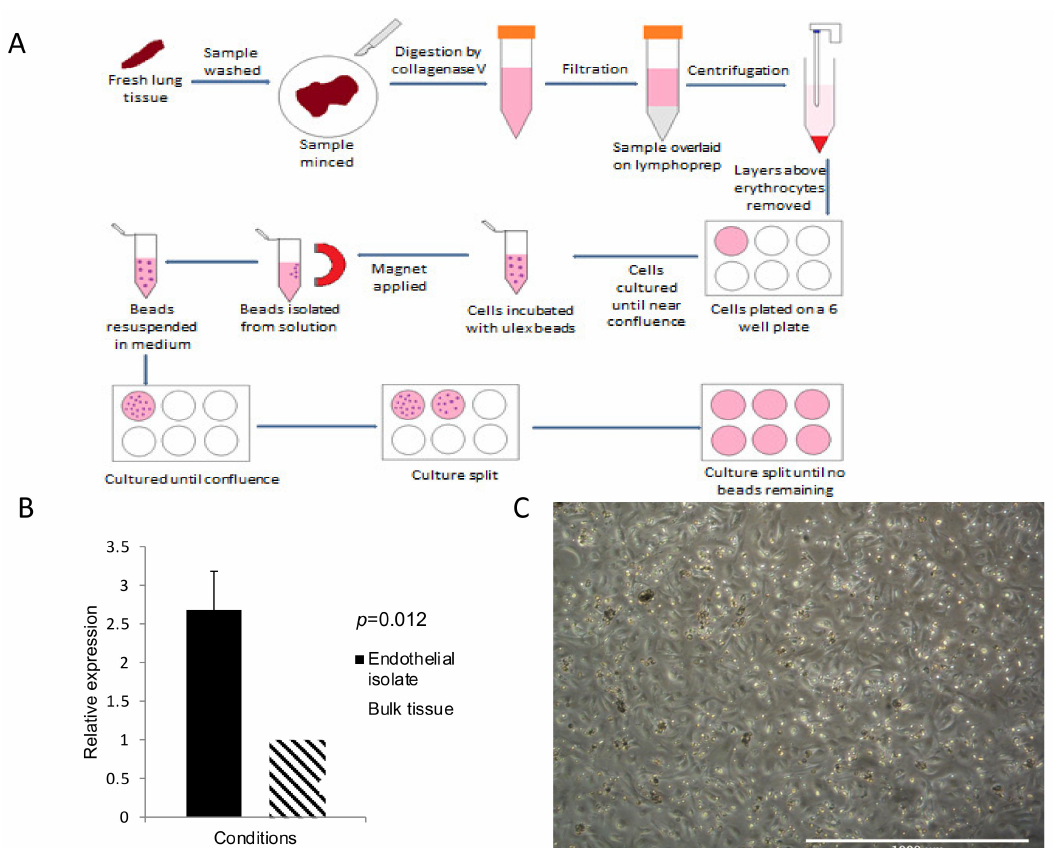
Figure 1. Isolation and culture of endothelial cells. ( A ) Workflow: Fresh lung is minced before being added to collagenase V, the digested sample is passed through a filter before being overlaid on lymphoprep, cell layers above the erythrocytes are removed and the cell pellet resuspended and placed in a 6-well plate. The cell culture is then incubated with Ulex-coated magnetic beads, which bind to endothelial cells, before a magnet is used to isolate the beads. Cells are used either for RNA extraction at this point, or the beads are resuspended and cultured by placement in a 6-well plate, the culture being split repeatedly until no beads remain. ( B ) Confirmation of isolation efficiency by qPCR: the bar chart represents the relative expression of CD31 in endothelial isolates in comparison to bulk tissue, normalised against flotillin 2. ( C ) Appearance of mixed lung cell culture on day five, extraction four. Primarily endothelial cells are seen, with some clumps of other cells. Scale bar represents 1000 µ